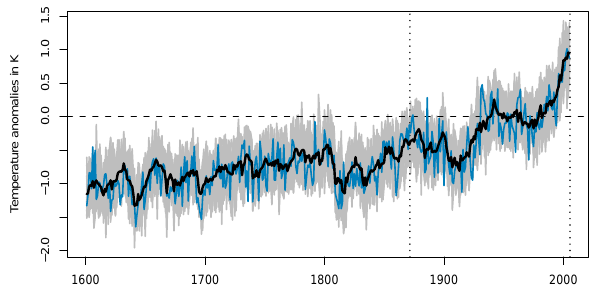
Fig. 1. Annual (November to October) average temperature north Fig.1. Annual(NovembertoOctober)averagetemperaturenorth of 20 ◦ N in the ensemble of ECHAM5.4 simulations as anomalies of20 ◦ NintheensembleofECHAM5.4simulationsasanomalies ofthe1961-90mean. Thegreyareadenotestherangeofthefirst of the 1961–1990 mean. The grey area denotes the range of the first 29individualsimulations,thethickblacklineisthecorresponding ensembleaverageandthethinbluelinedenotesthethirtiethsimu- 29 individual simulations; the thick black line is the corresponding lation(thereference). ensemble average and the thin blue line denotes the 30th simulation (the